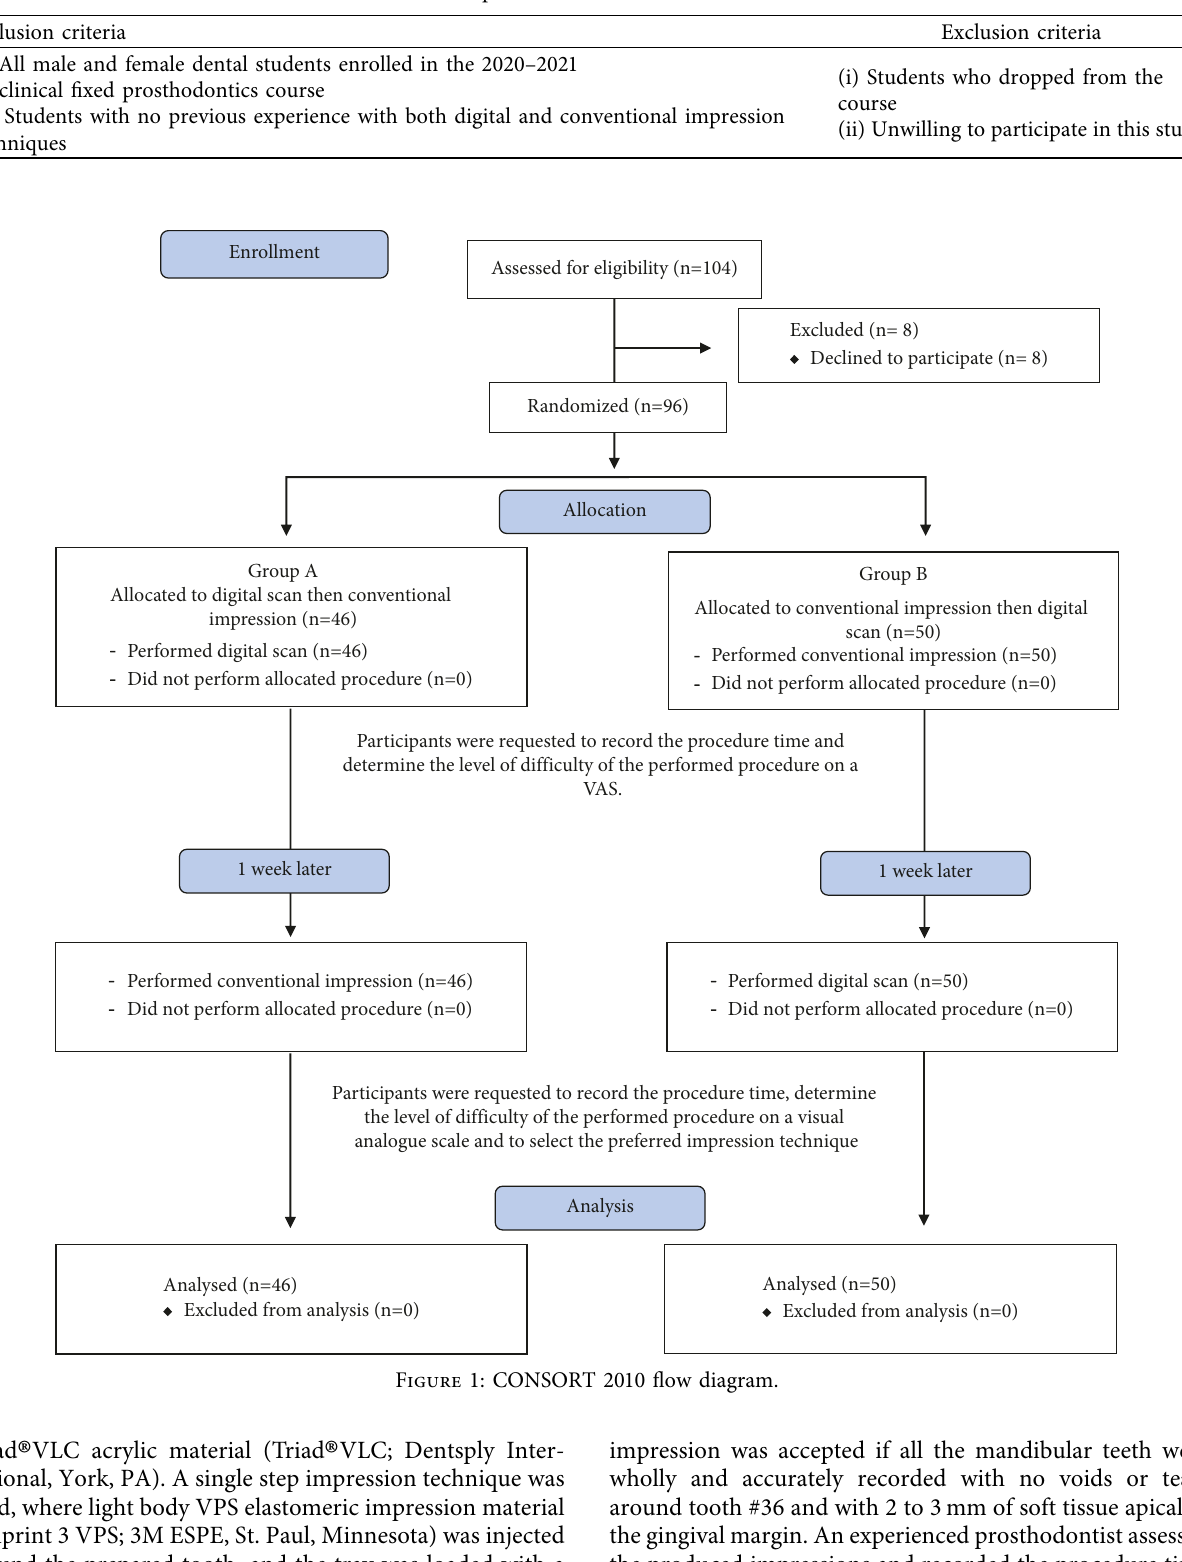
Table 1: Participants’ inclusion and exclusion criteria.